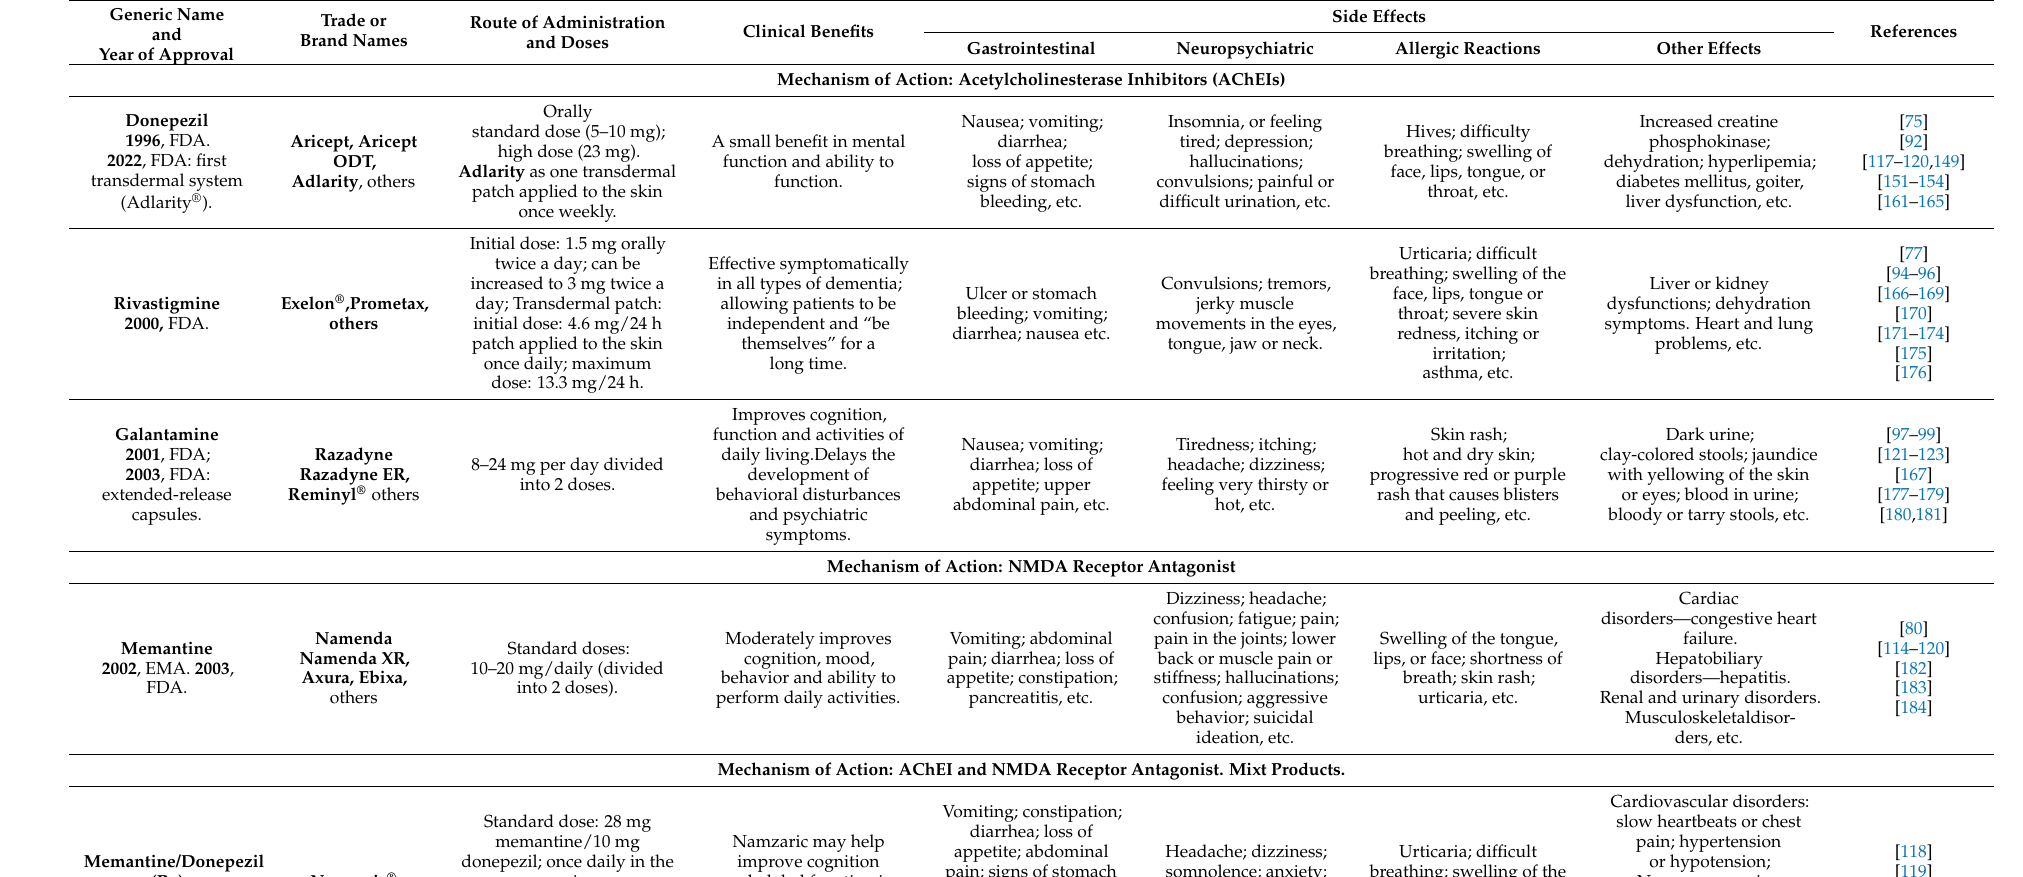
Table 2. Characteristics of current FDA-approved drugs for Alzheimer’s